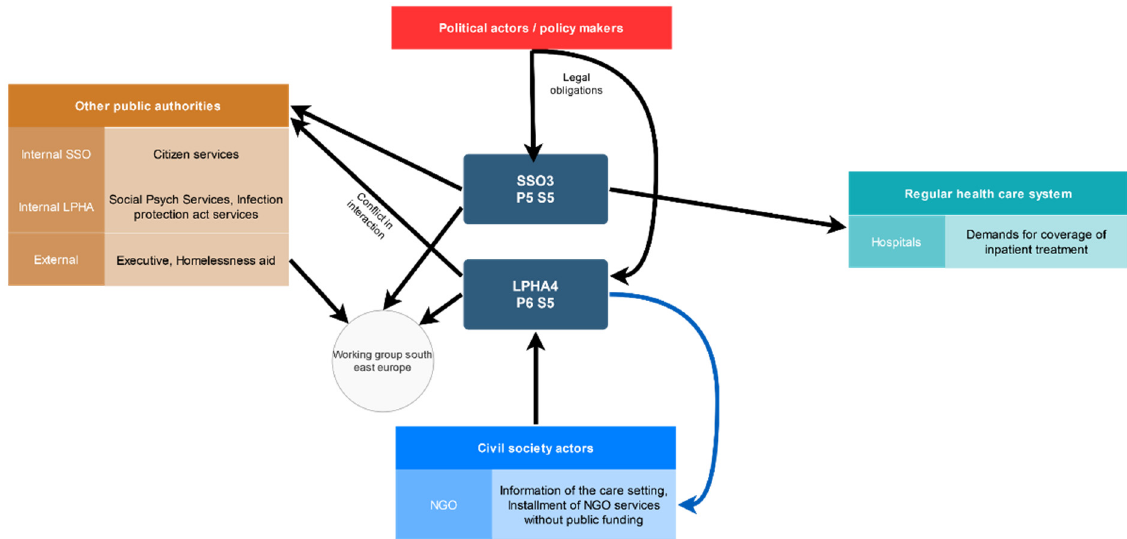
Figure 2. Courtesy translation of exemplary graphical presentation of the institutions and network of actors in care setting 5 (S5) as mentioned by the interviewed experts. Visualisation is to aid individual case analysis and does not present a formal systematisation of care settings. Network connections are primarily pooled from the code category “Netzwerk”. Black arrow indicates general network connection, blue arrow indicates the specific relation type “outsourcing”, based on the code “Outsourcing (Ehrenamtlich)”, indicating that a certain service is provided by an NGO or physician without complete public funding. Supplementary File S3 contains the graphical presentations of settings 1–7. Abbreviations: Local public health authority (LPHA); Social security office (SSO); interview person (P), the setting (S). Thickness of arrows does not indicate stronger/weaker